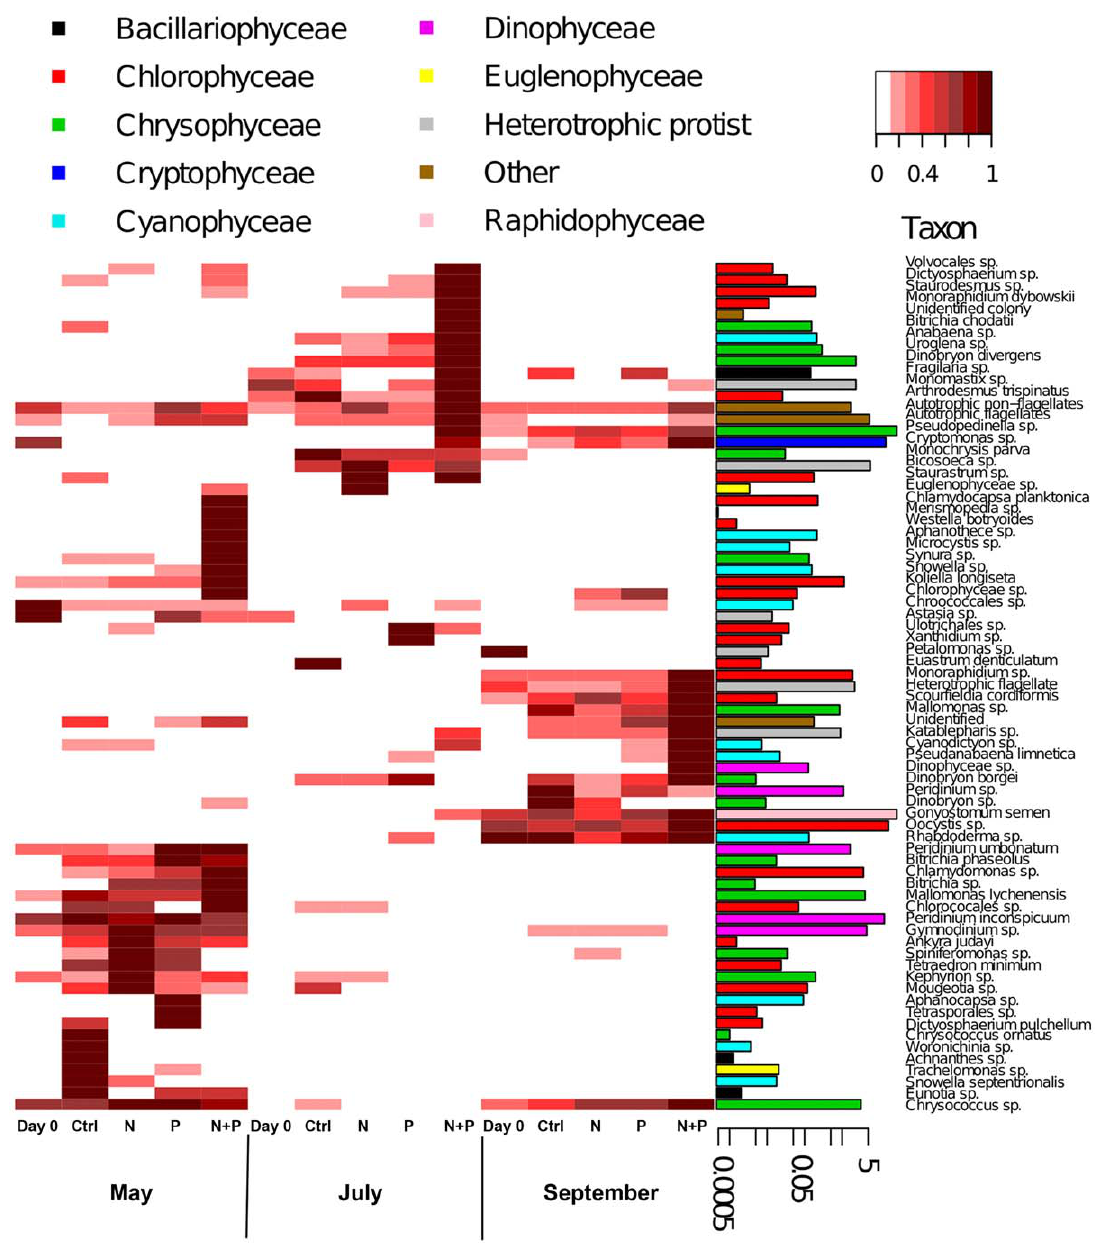
Figure 6. Heatmap visualizing patterns in biovolumes of phytoplankton taxa with the barplots showing their relative contributions to the entire phytoplankton biovolume. Biovolumes were standardized by relativizing each taxon against its maximum biovolume. The barplots show the actual biovolume (% of taxa) of each taxa in logarithmic scale. * = G. semen contributed 64 % of the whole phytoplankton biovolume in all experiments. To visualize the biovolumes of other taxa, this bar was truncated to same height with the second most abundant taxa, Pseudopedinella .